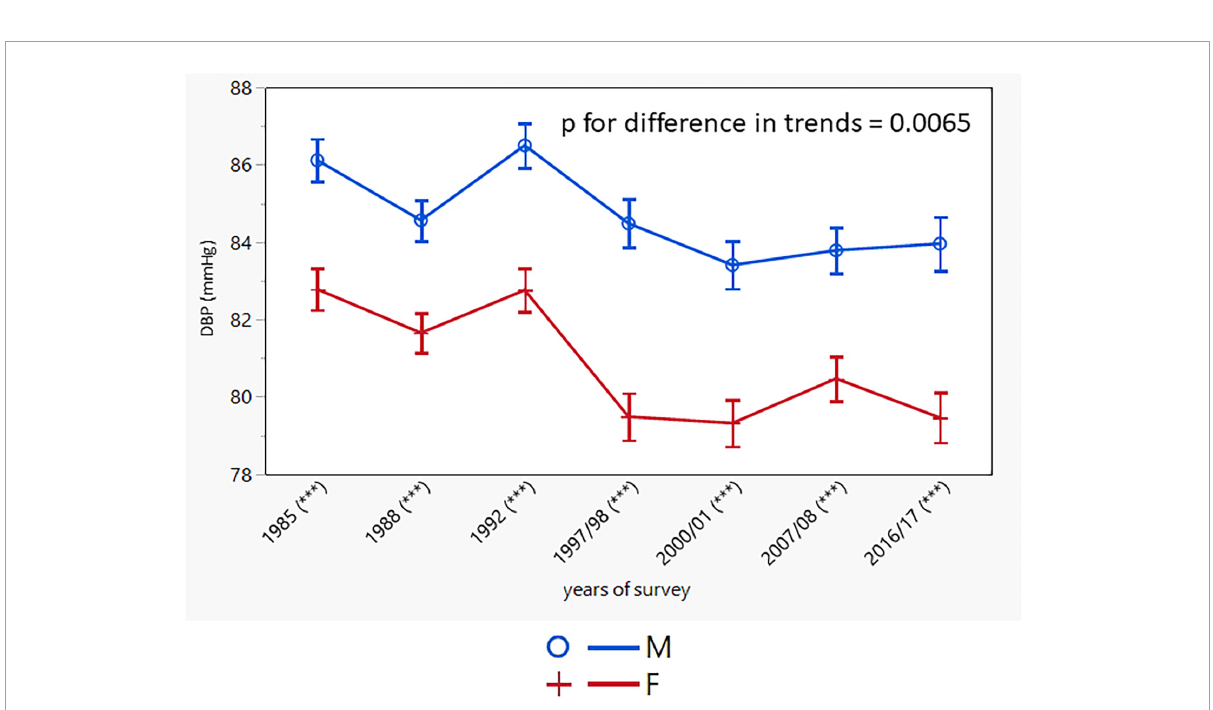
FIGURE3 Age-adjusted trends in diastolic blood pressure (95% confidence interval). M, males; F, females; p for differences in trends between males and females. Asterisks indicates in brackets after survey years the sex differences in respective surveys after Bonferroni correction; *** p <